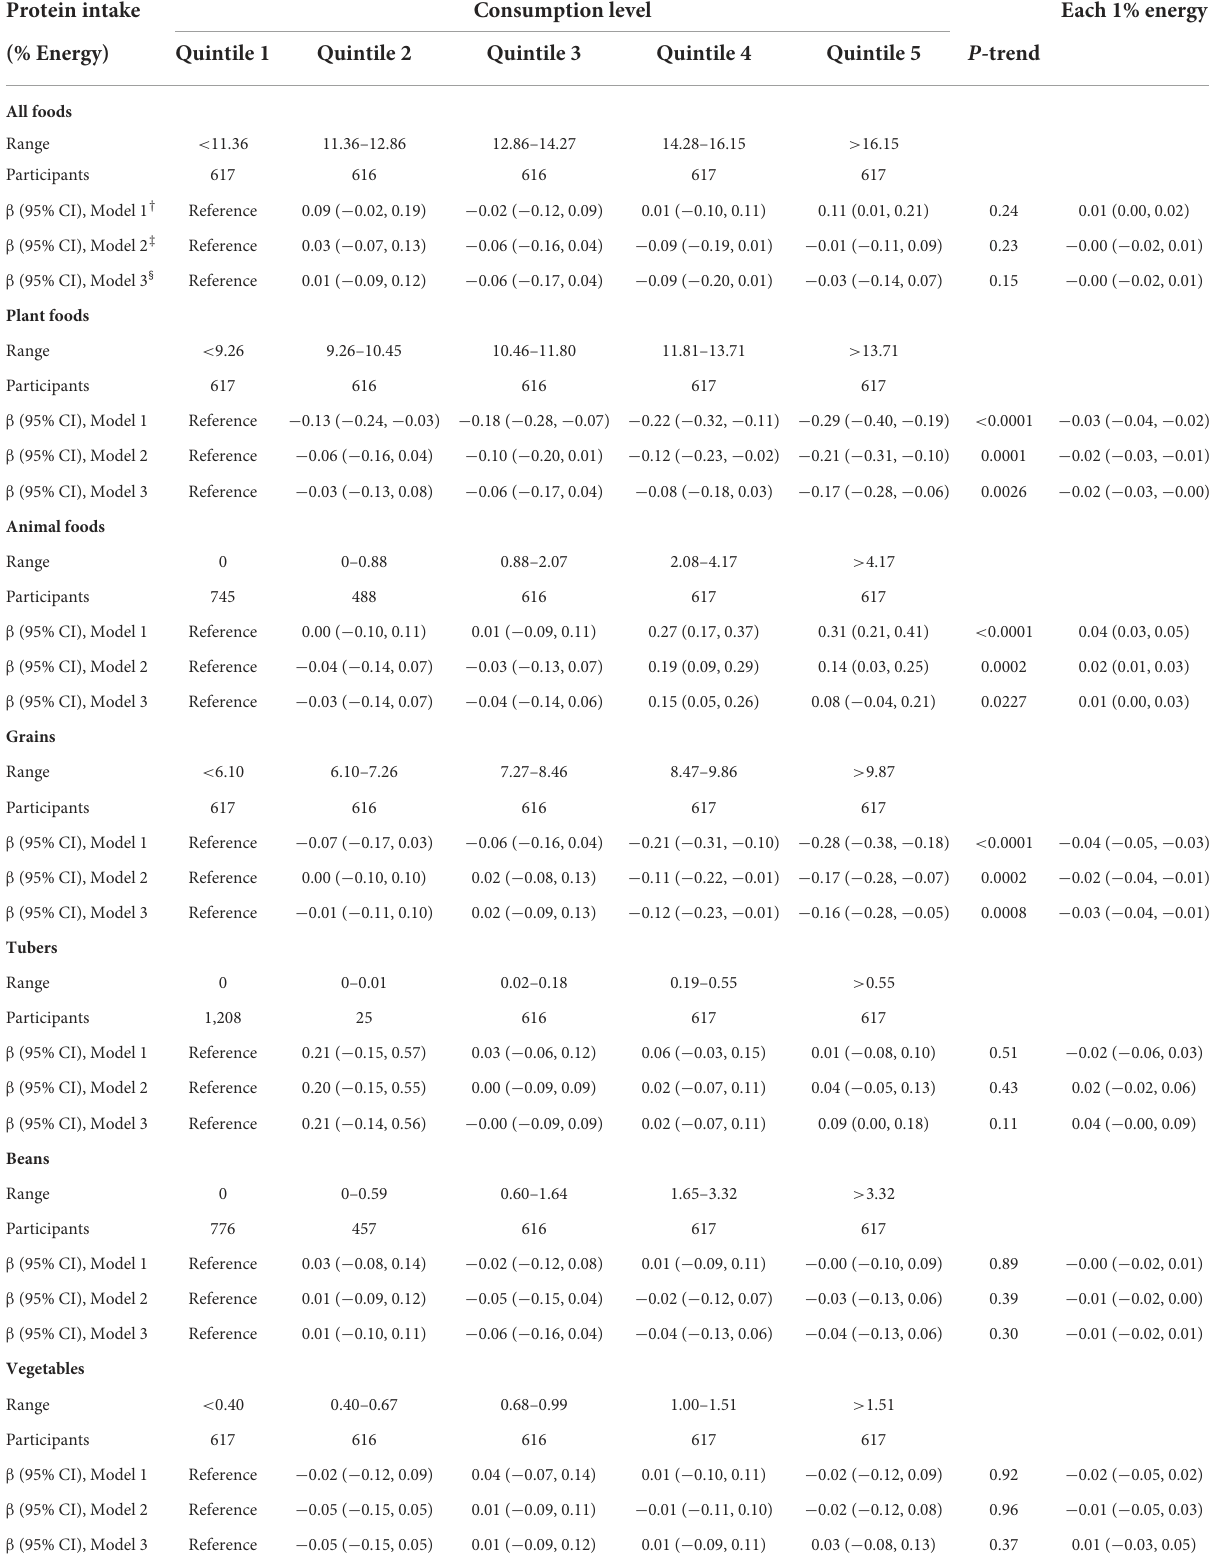
TABLE 3 Protein intake from different food sources and the change in composite cognitive score *